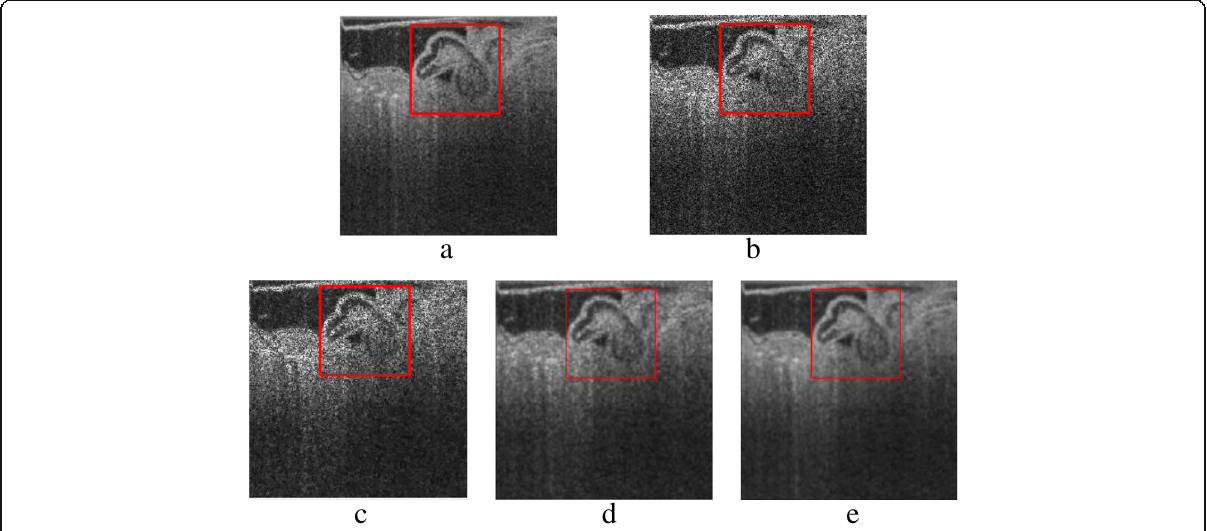
Fig. 6 Recovered ultrasonic images via different methods. a Original image, b noisy image (PSNR = 29.2360, SSIM = 0.8174), c nonlocal-AA method (PSNR = 31.2127,SSIM= 0.8488), d nonlocal-SO method (PSNR = 32.3298, SSIM = 0. 8878), and e proposed method (PSNR = 32.6496, SSIM = 0.8994)